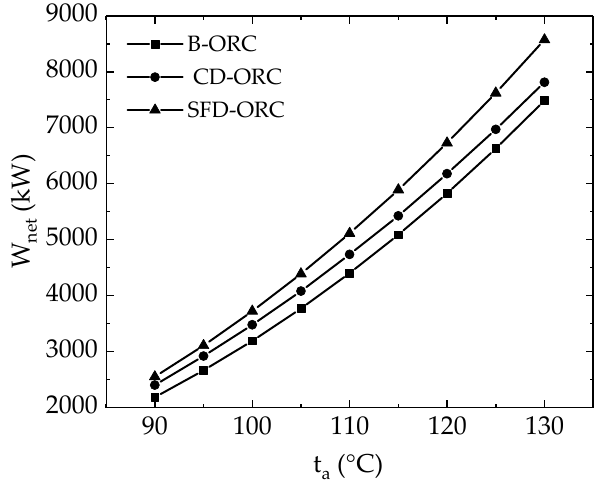
Figure 15. The variation in the net output power with t a